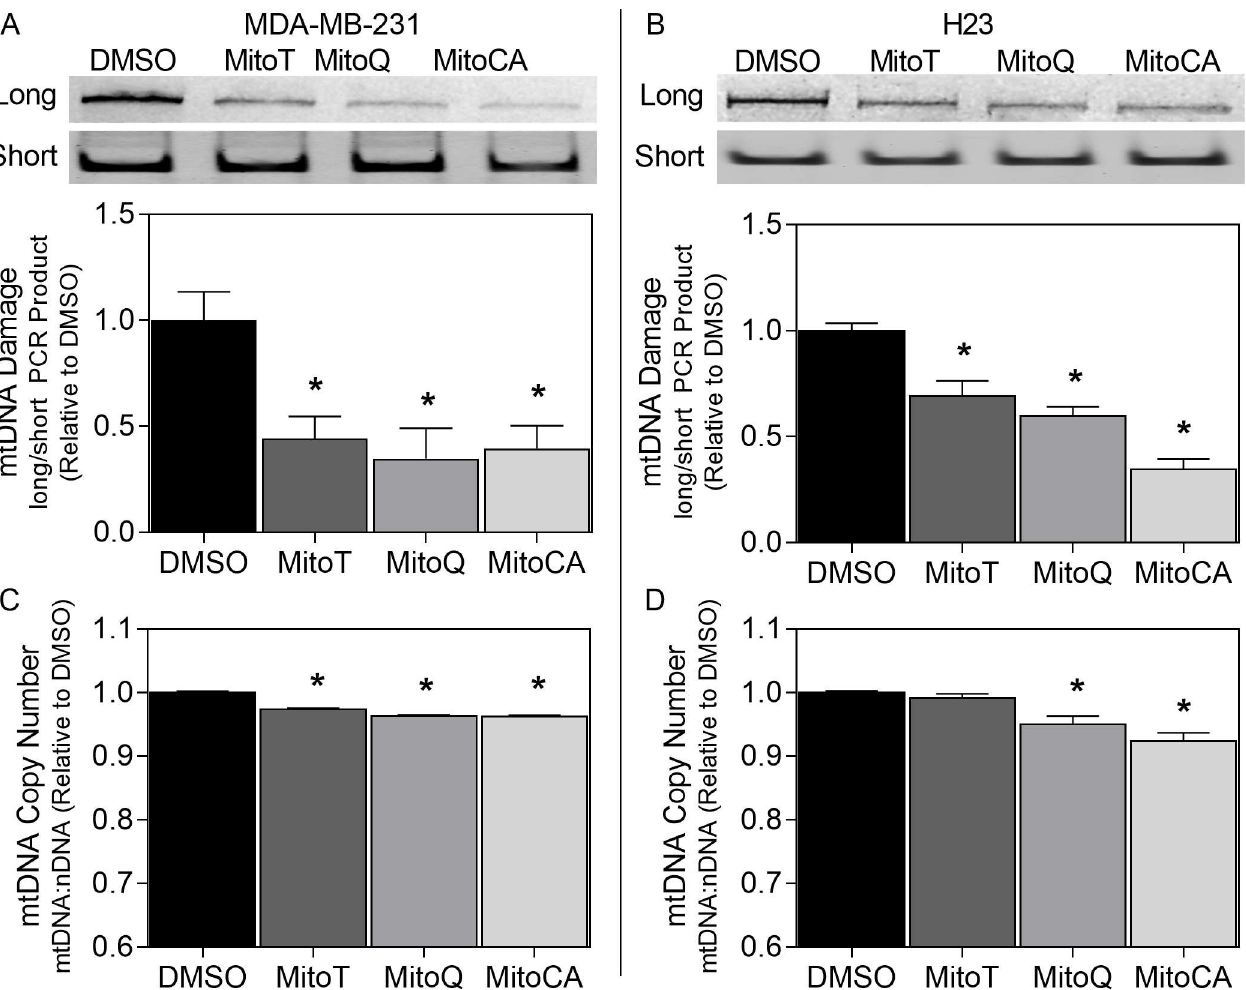
Fig 2. Mitochondrial DNA integrity. mtDNA damage (A-B) and copy number(C-D) in MDA-MB-231 (A,C) and H23 (B,D) cells after exposure to DMSO [(0.02%) black bars], MitoT (dark gray bars), MitoQ (gray bars) or MitoCA (light gray bars) at 2 μ M for 24 hours. mtDNA fragmentation (A-B) was evaluatedusing PCR amplification of a long mitochondrial sequencerelative to a short mitochondrial sequence. Band intensitiesof PCR products were quantitated using densitometry. In A-B, gels are representative images for PCR products. In C & D, mitochondrial copy numberwas assessed by amplification of short regions of house-keepinggenesin both nDNA and mtDNA. Bars depict the mean ratio of long to short band intensities(A-B) or the mean ratio of mtDNA:nDNA (C-D) relative to the DMSO treatment +/-1 SEM. Asterisks show statistical significance